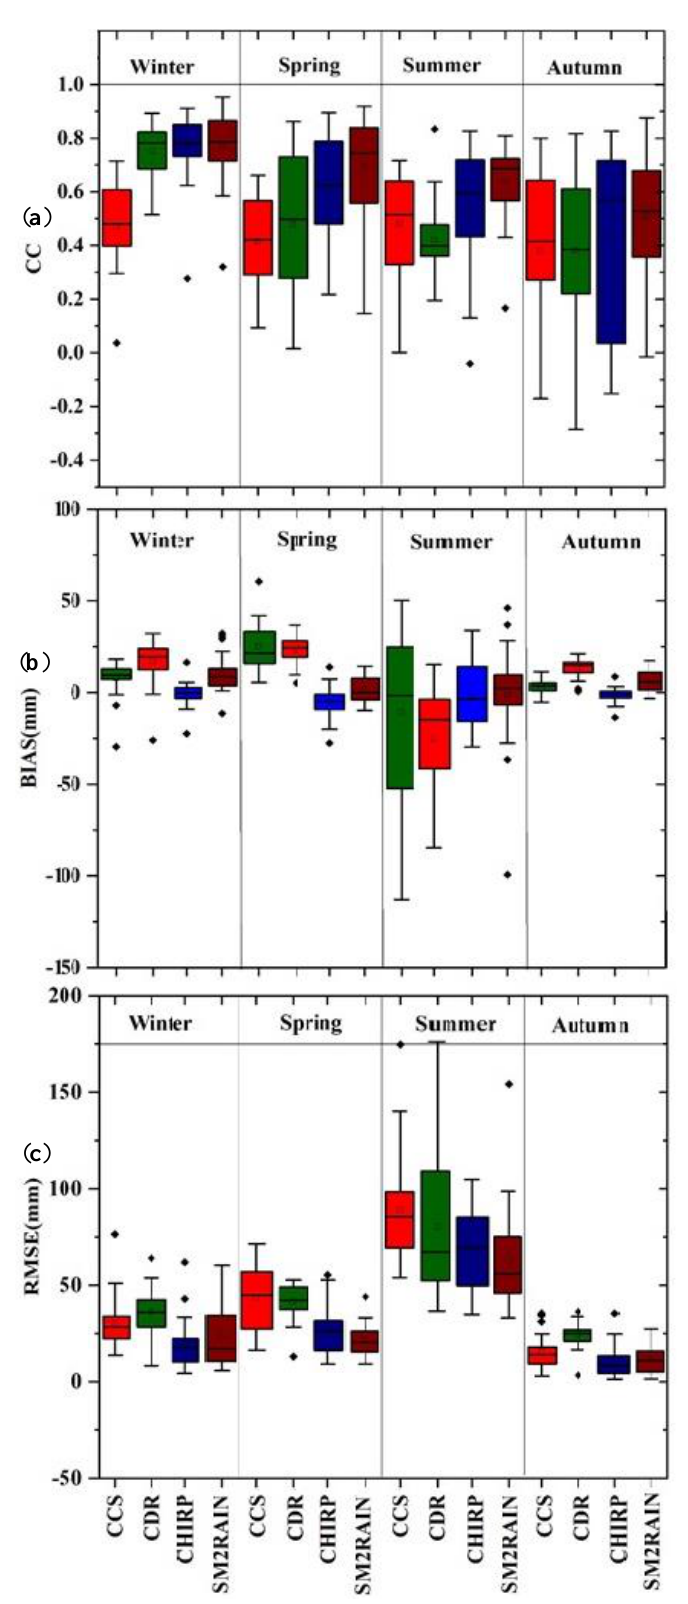
Figure 10. Seasonal variations in the CC, RMSE, and Bias of the PERSIANN-CCS, PERSINN-CDR, CHIRPS-2.0, and SM2Rain-ASCAT products estimated for the Punjab Province of Pakistan.